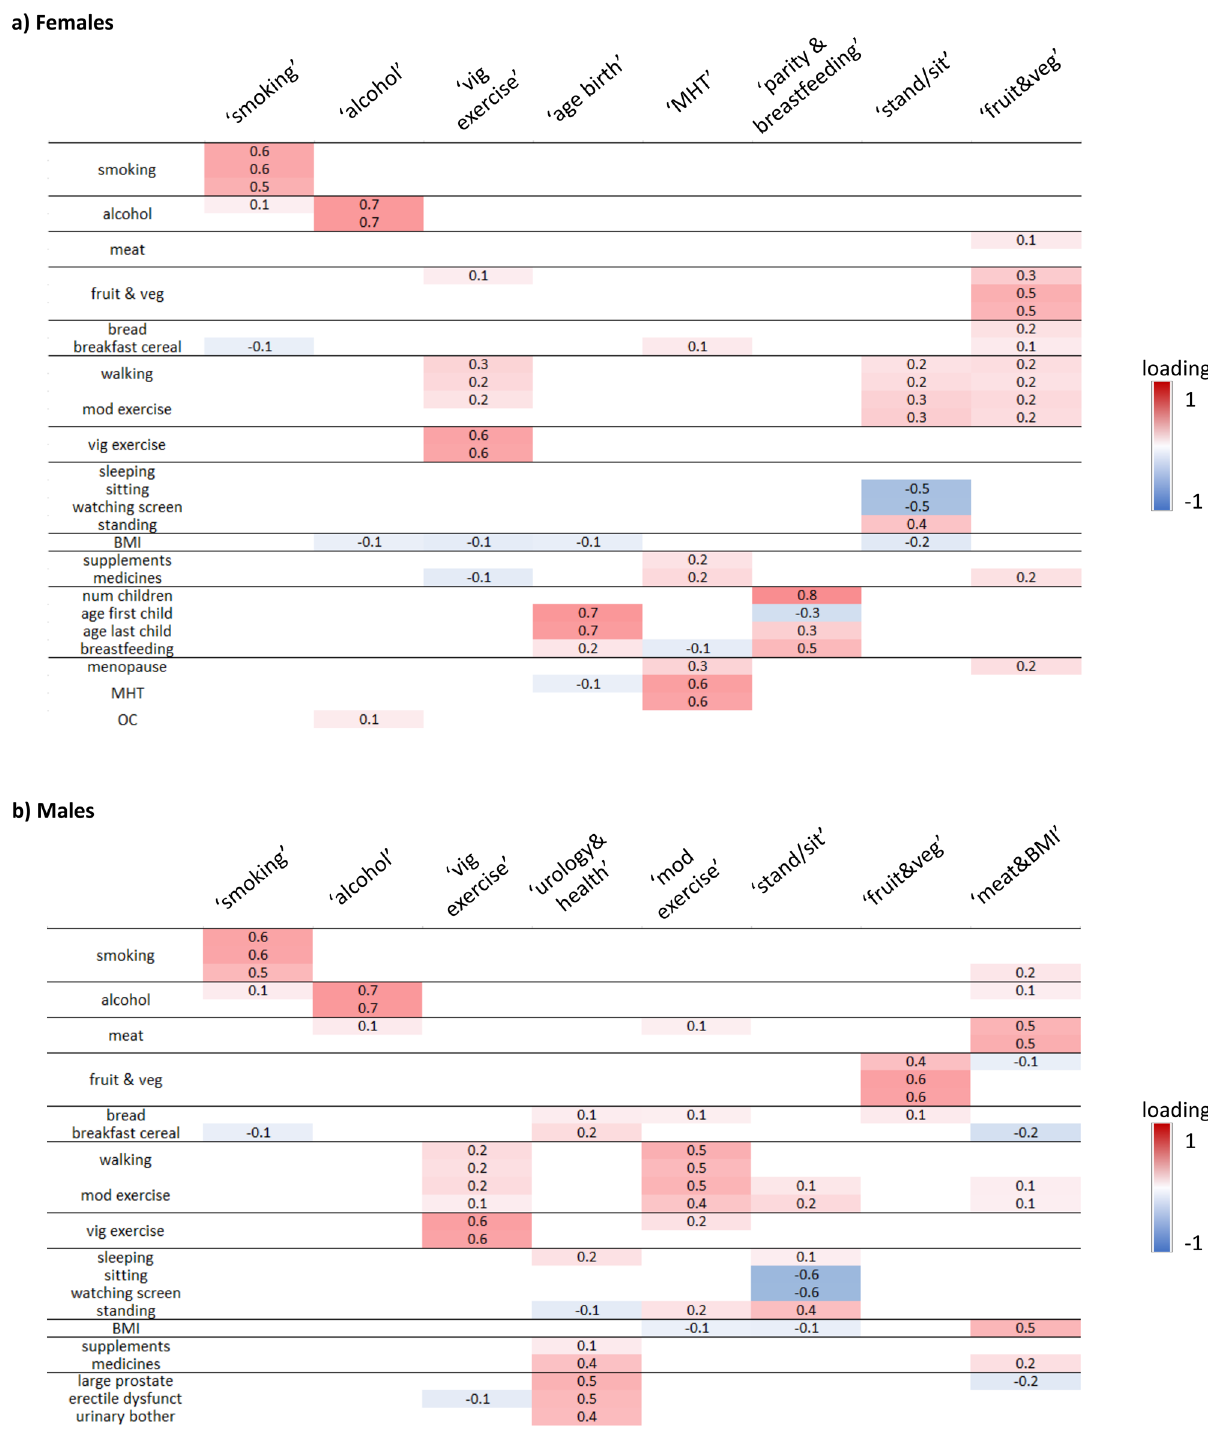
Figure 2. Combined factors for ( a ) females and ( b ) males. Original cancer risk variables shown in rows and combined factors in columns; combined factor labels reflect highest absolute loadings. For clearer visualisation only, loadings with absolute value ≥ 0.1 are shown and original variables are grouped into categories (full results: Supplementary Table S5). vig vigorous, age birth age at childbirth, MHT menopausal hormone therapy, stand/ sit standing/sitting, veg vegetables, mod moderate, BMI Body Mass Index, OC hormonal contraceptives, dysfunct